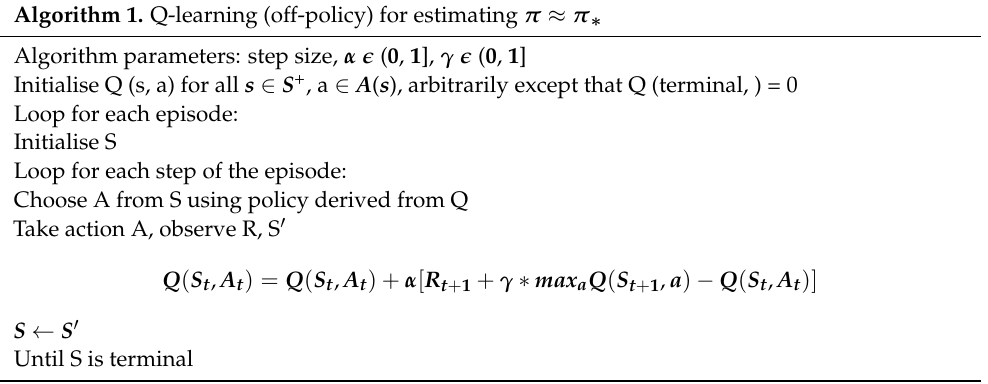
Algorithm 1. Q-learning (off-policy) for estimating π ≈ π